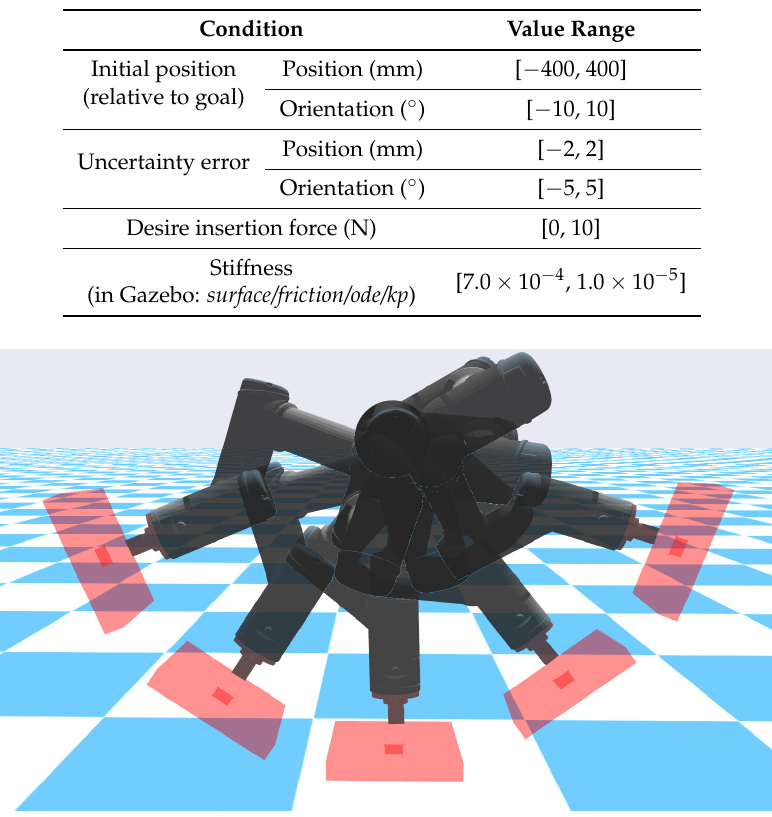
Figure 6. Simulation environment. Overlay of randomizable goal